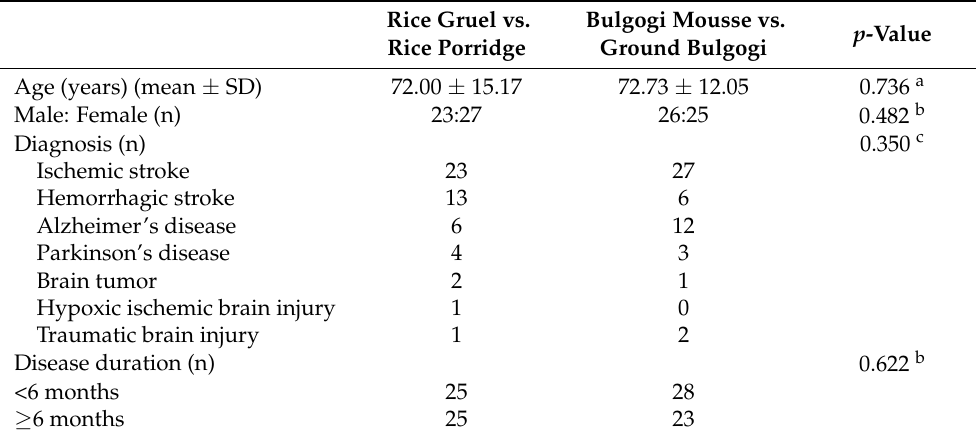
Table 2. Demographic data of the study participants.